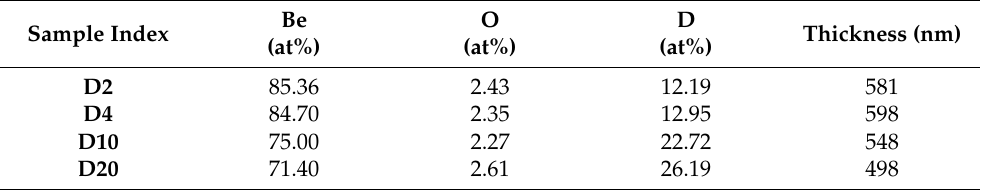
Table 2. Chemical composition and thickness of Be-D layers resulted from the simulation of experi- mental RBS